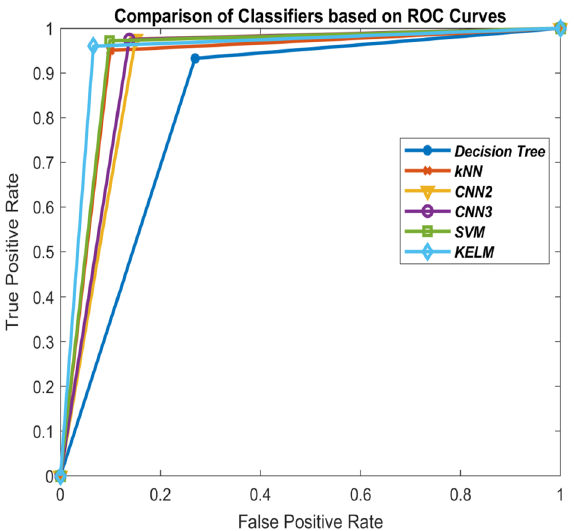
Figure 12. Comparison of the classifiers based on ROC curves (50–50 train-test ratio) of CoViD19+ve and